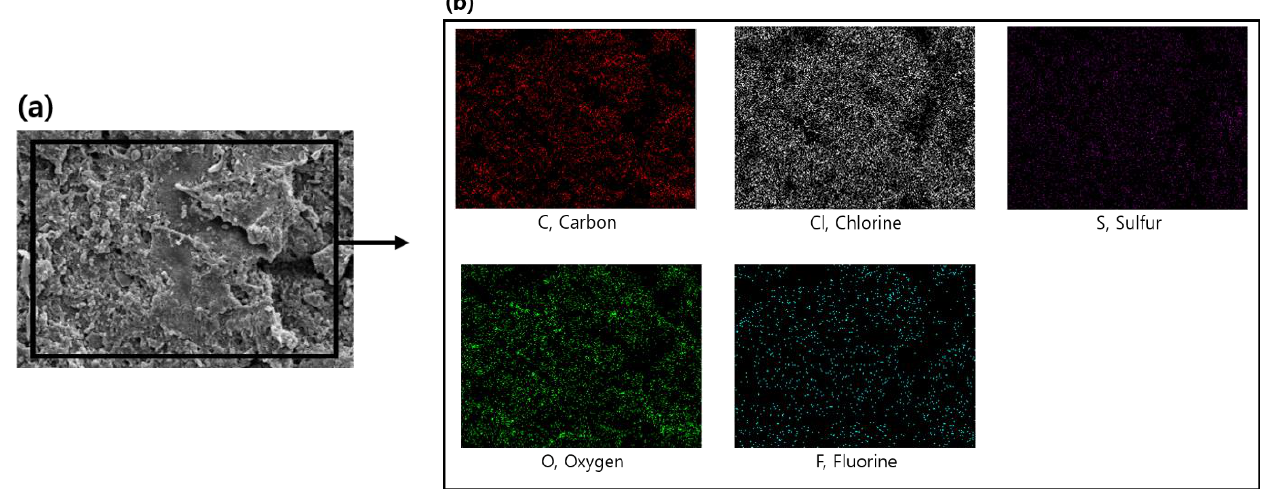
Figure 11. SEM-EDS investigation on the sheath of a 40 year accelerated aged cable at ( a ) 500 × magnification and ( b ) its elemental mapping.